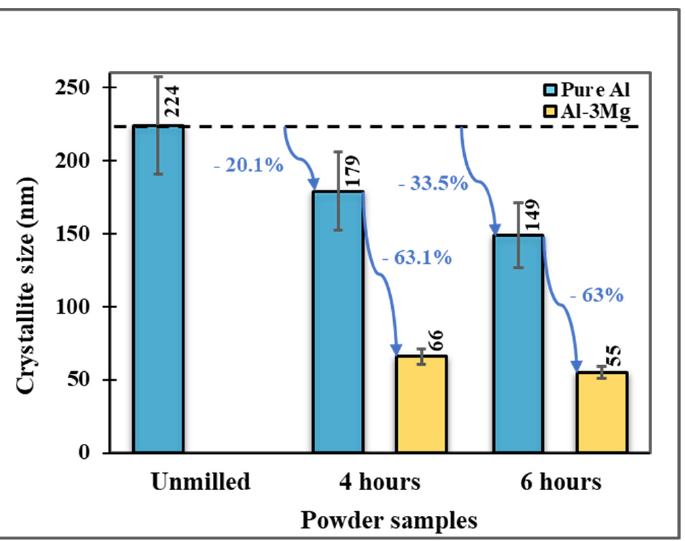
Figure 8. Plot showing the effect of Mg doping on the crystallite sizes for pure Al and Al-3Mg for varying cryomilling times.